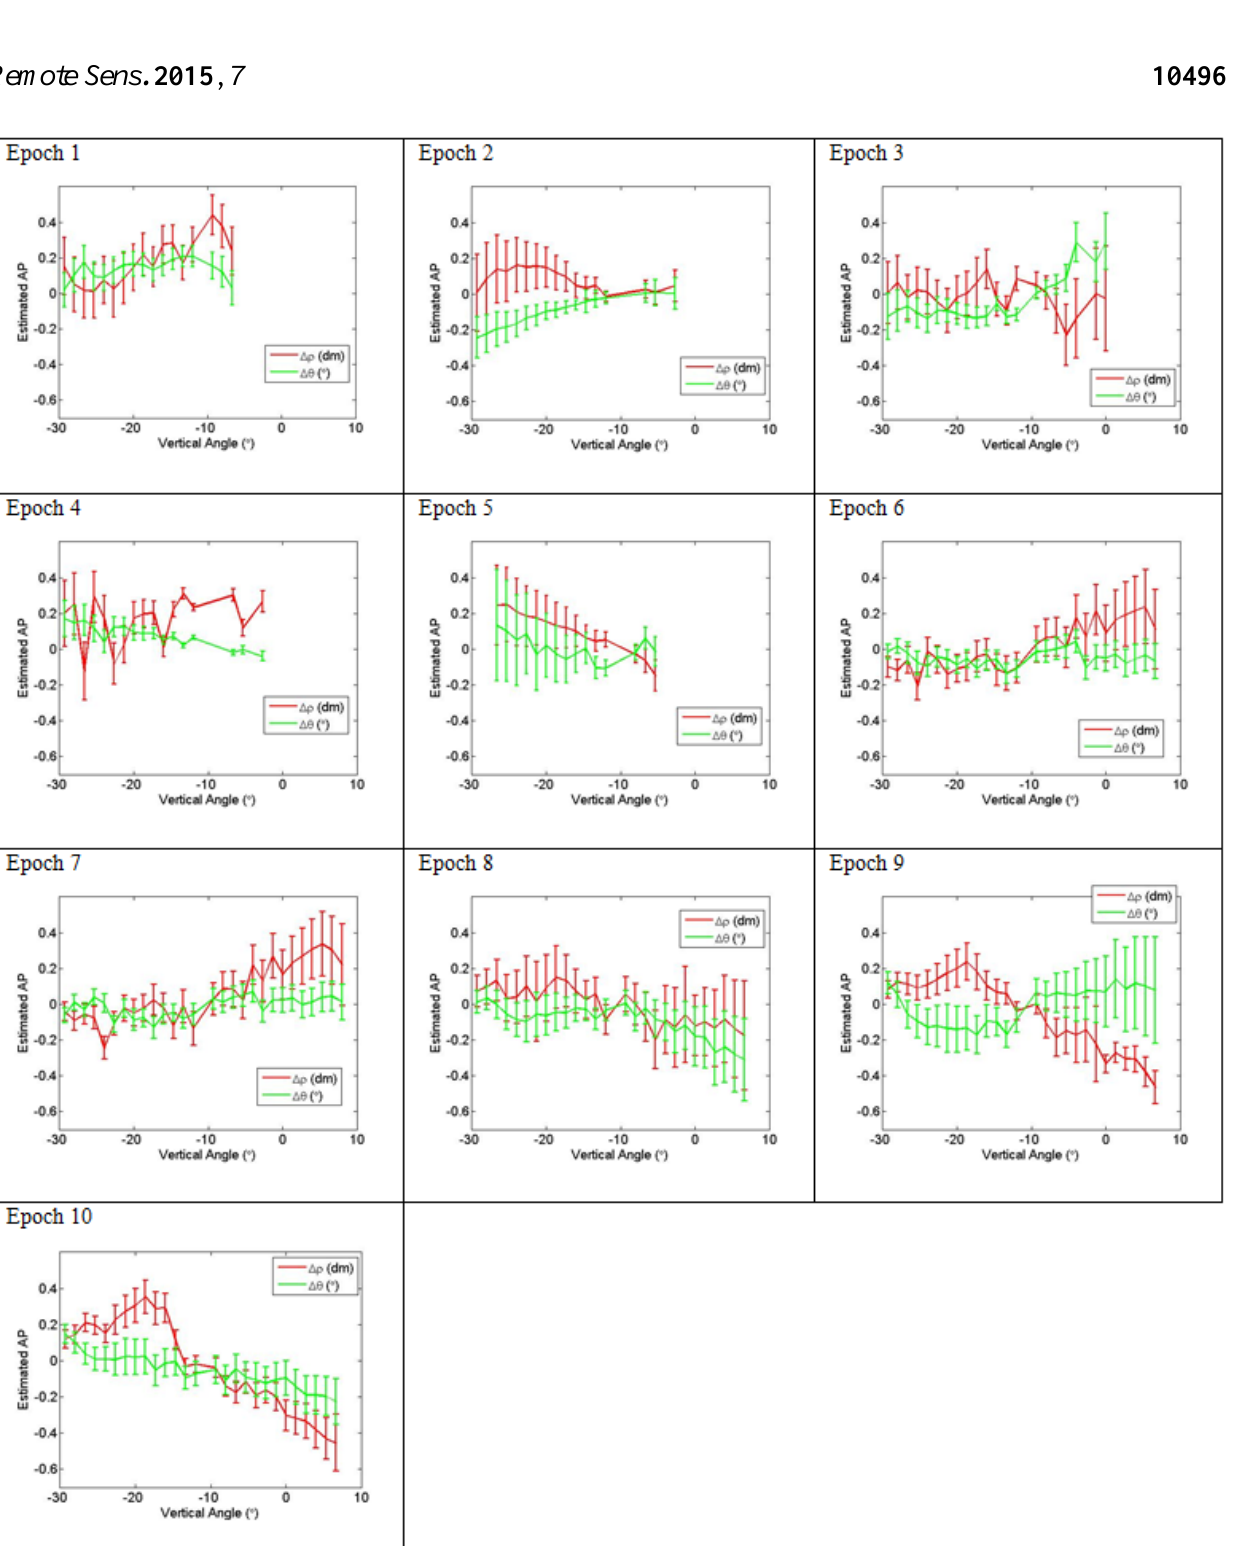
Figure 17. Estimated parameters and their precisions by the proposed calibration in kinematic mode for Dataset 4 over 10 epochs (10 rotations, ~1.4